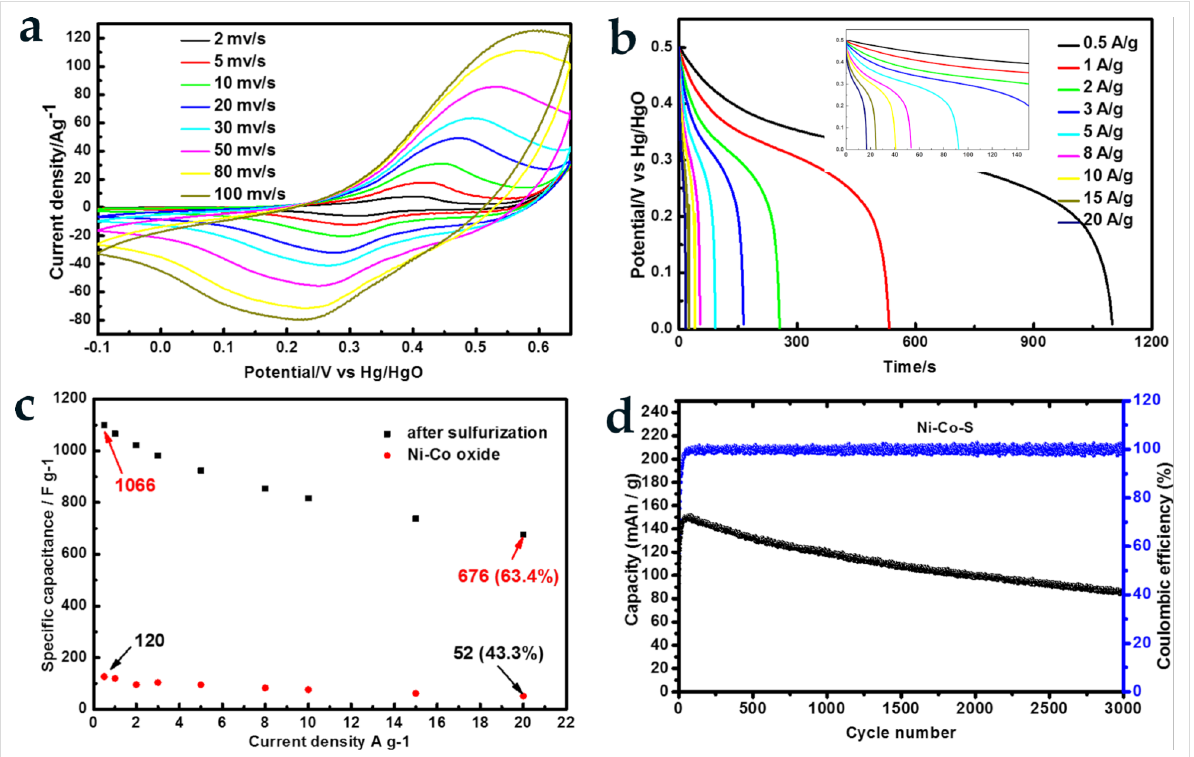
Figure 3: (a) CV curves at sweep rates from 2 to 100 mV·s − 1 (vs Hg/HgO); (b) GCD curves at different current densities; (c) comparison of specific capacitance retention with precursor Ni x Co 3 − x O 4 and Ni 1 − x Co x S 2 ; (d) cycle stability of Ni 1 − x Co x S 2 .